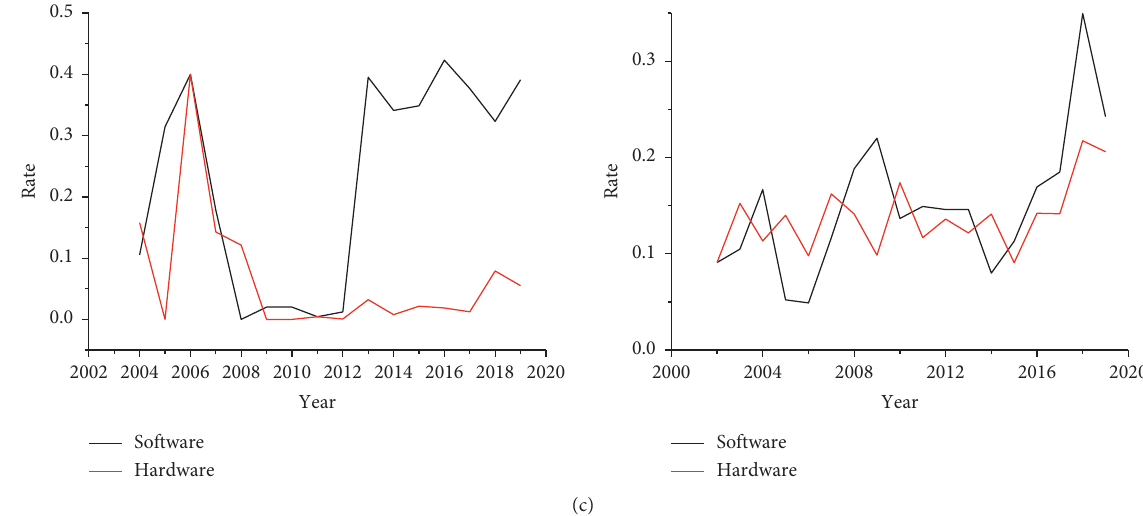
Figure 8: “Hardware” and “Software” topics vary with year in papers (left side) and patents (right side) in (a) amount; (b) relative proportion; (c) growth rate.